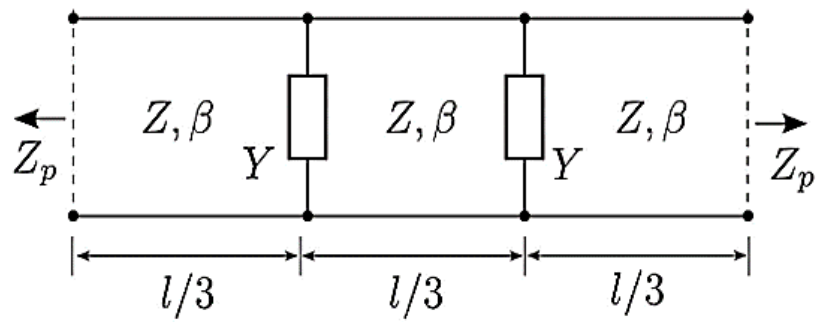
Figure 2. Equivalent microwave network circuit of the terahertz (THz) filter.